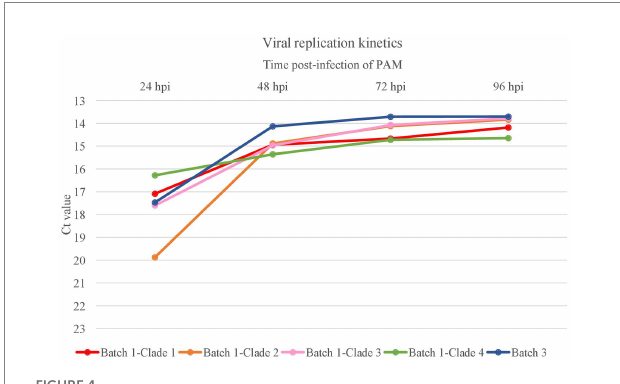
FIGURE 4 Virus replication kinetics of the different viral clades identified in the